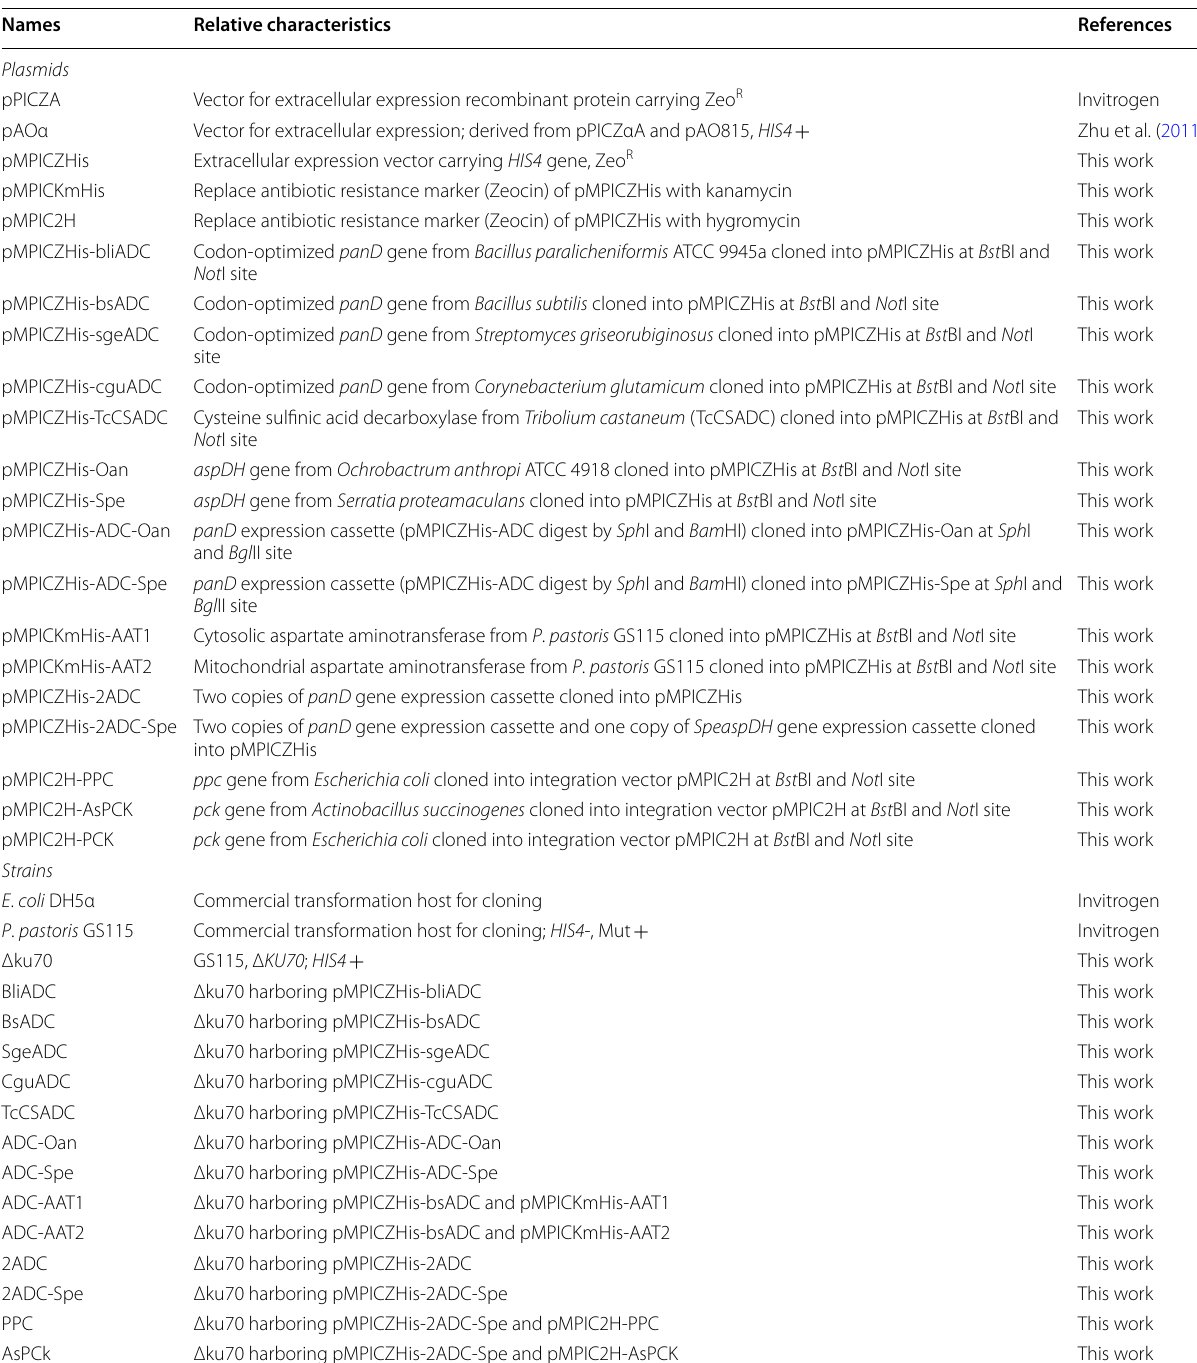
Table 2 Plasmids and strains constructed in this